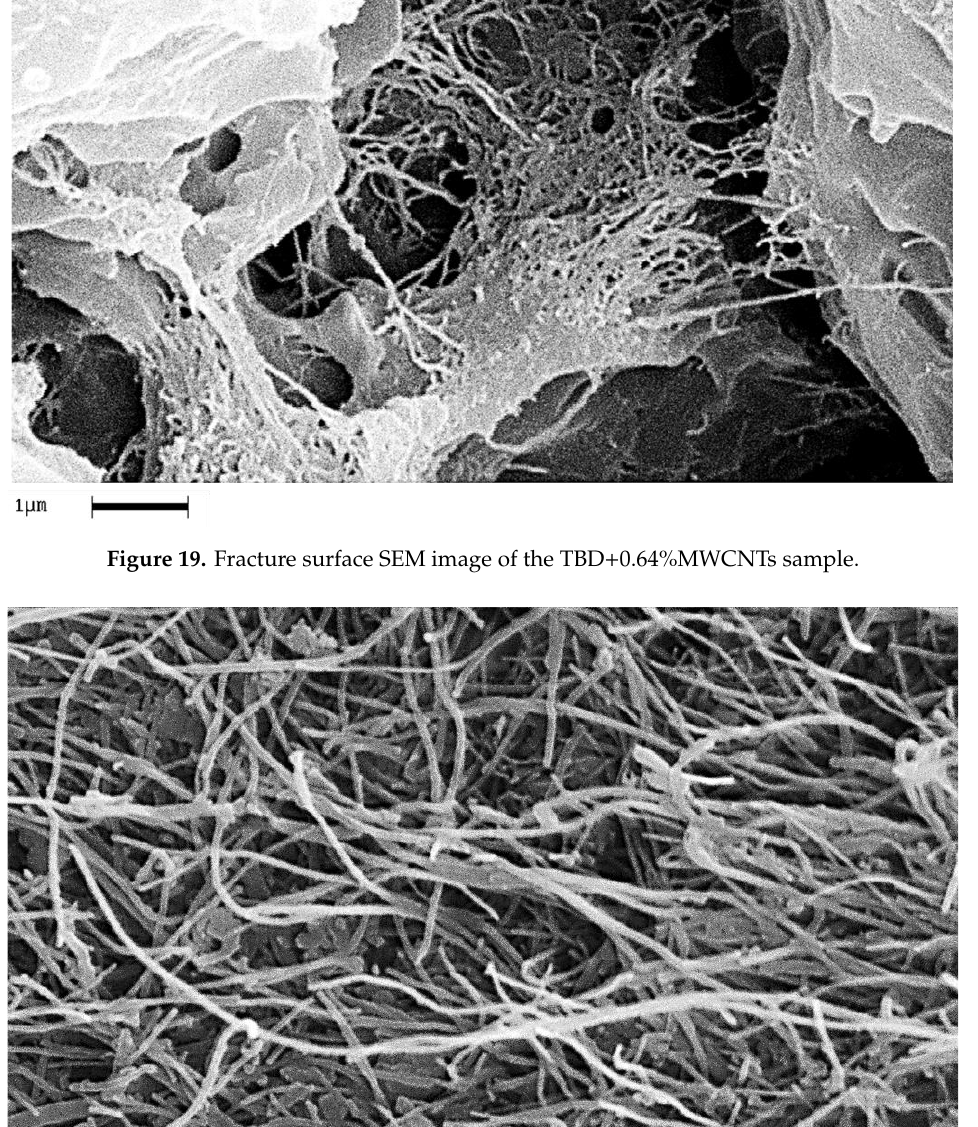
Figure 20. Fracture surface SEM image of the TBD+1%CNFs heat-treated sample.